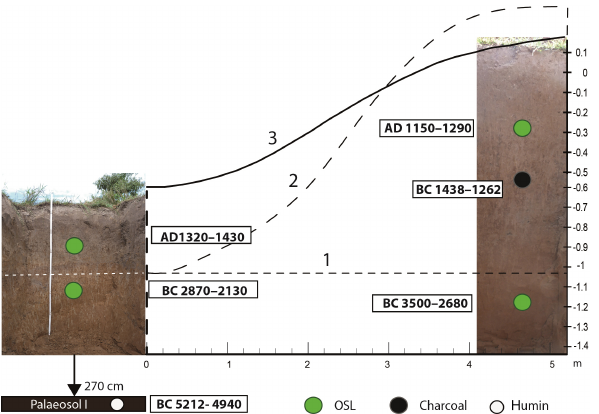
Figure 9. Reconstruction of Field 2 illustrating the three suggested different phases: (1) ancient surface before the construction of the fields (short dashed line), (2) original field profile (long dashed line) and (3) present-day profile of abandoned field (solid